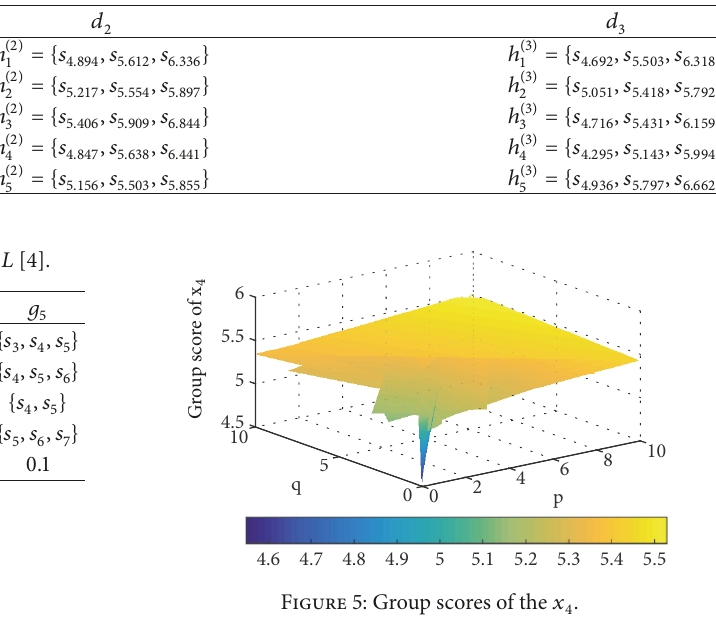
Table 8: Individual comprehensive evaluation values 𝐻 .